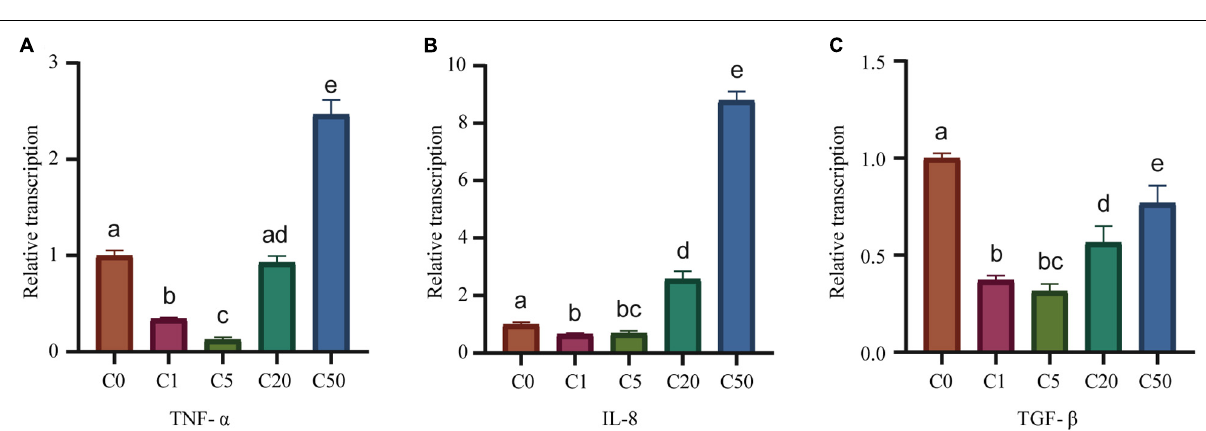
OTU numbers of the gut microbiota in the C5, C20, and